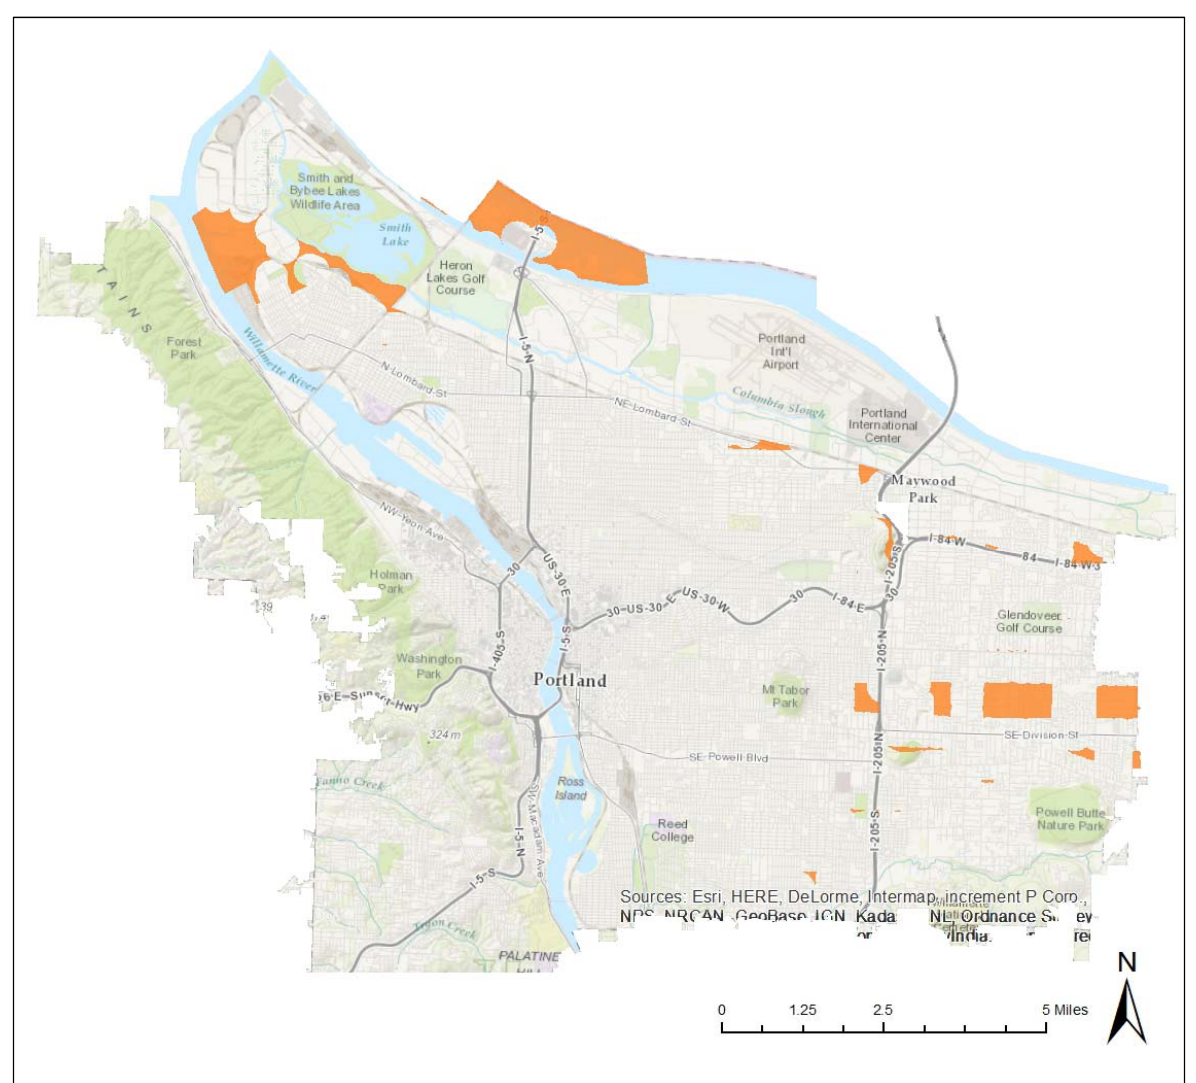
Figure 10. Potential Locations for Produce Stands to Increase Access to Fresh